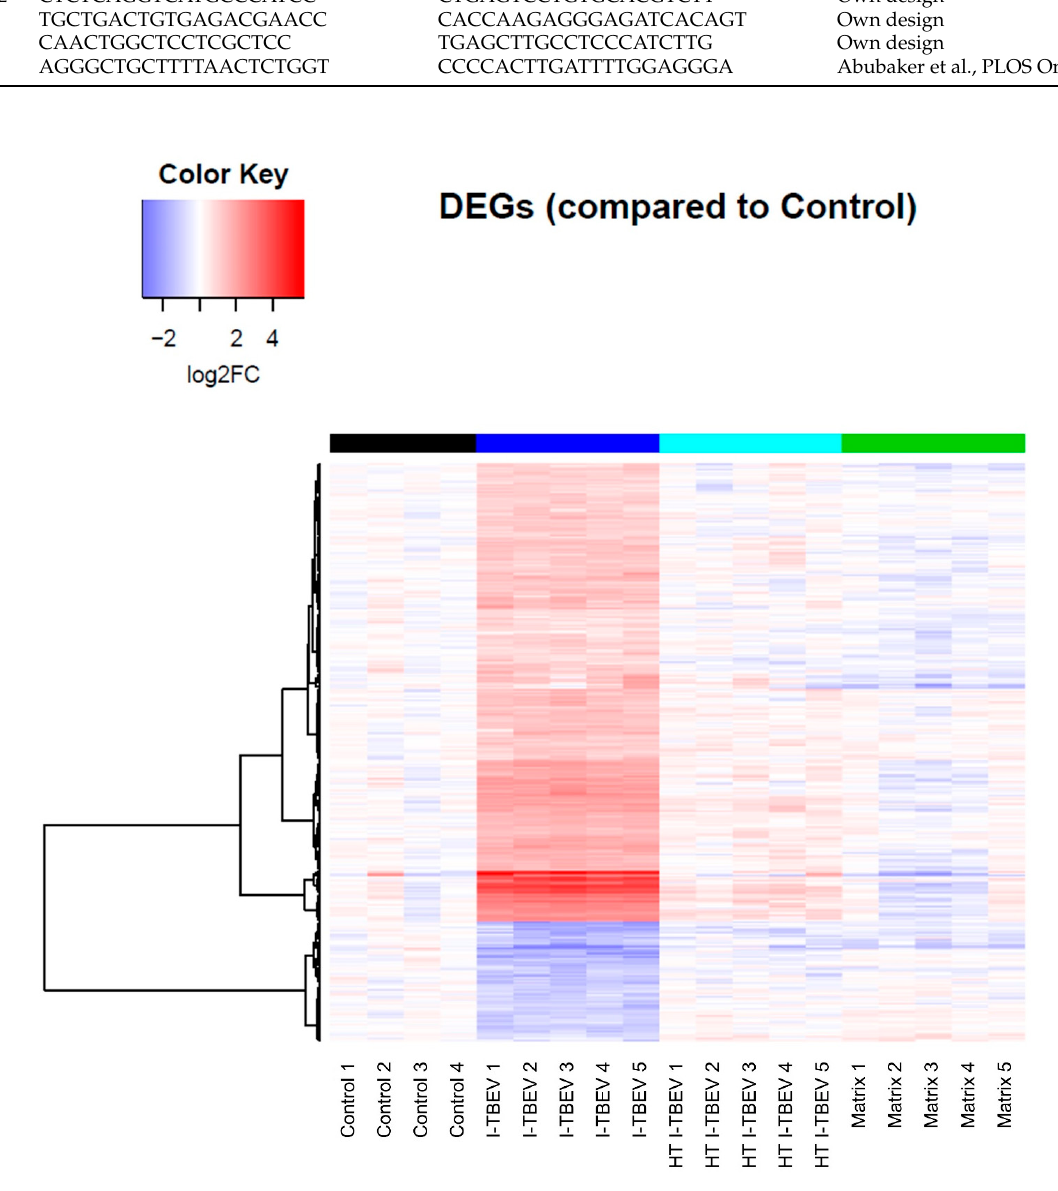
Figure A1. Transcriptional analysis of I-TBEV-treated PBMCs. Heatmap showing the fold change (FC) of differentially expressed genes (DEGs) in each sample, normalized to the control group.